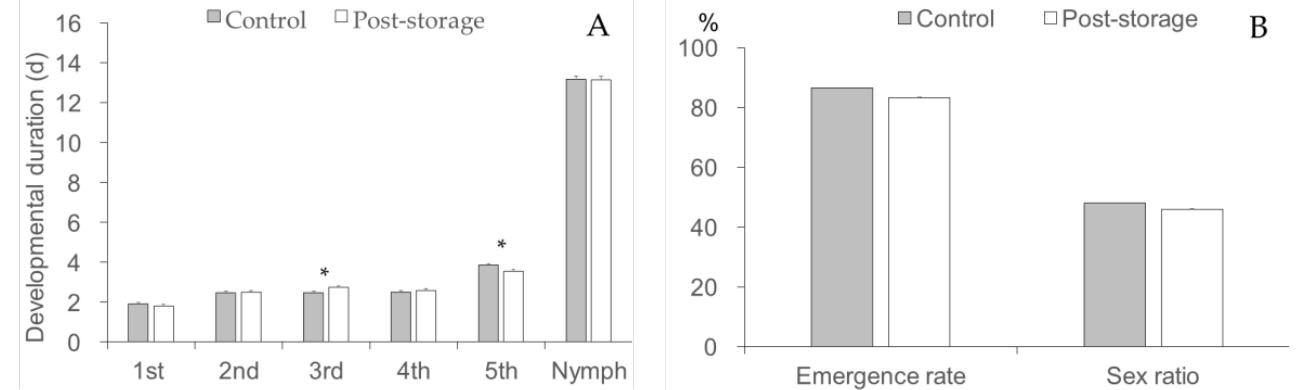
Figure 4. ( A ) Developmental duration; ( B ) emergence, and sex ratio (F1 generation of post-storage and control Cyrtorhinus lividipennis adults). The data represent mean ± SE. * shows a significant difference (independent sample t -test, p = 0.05).